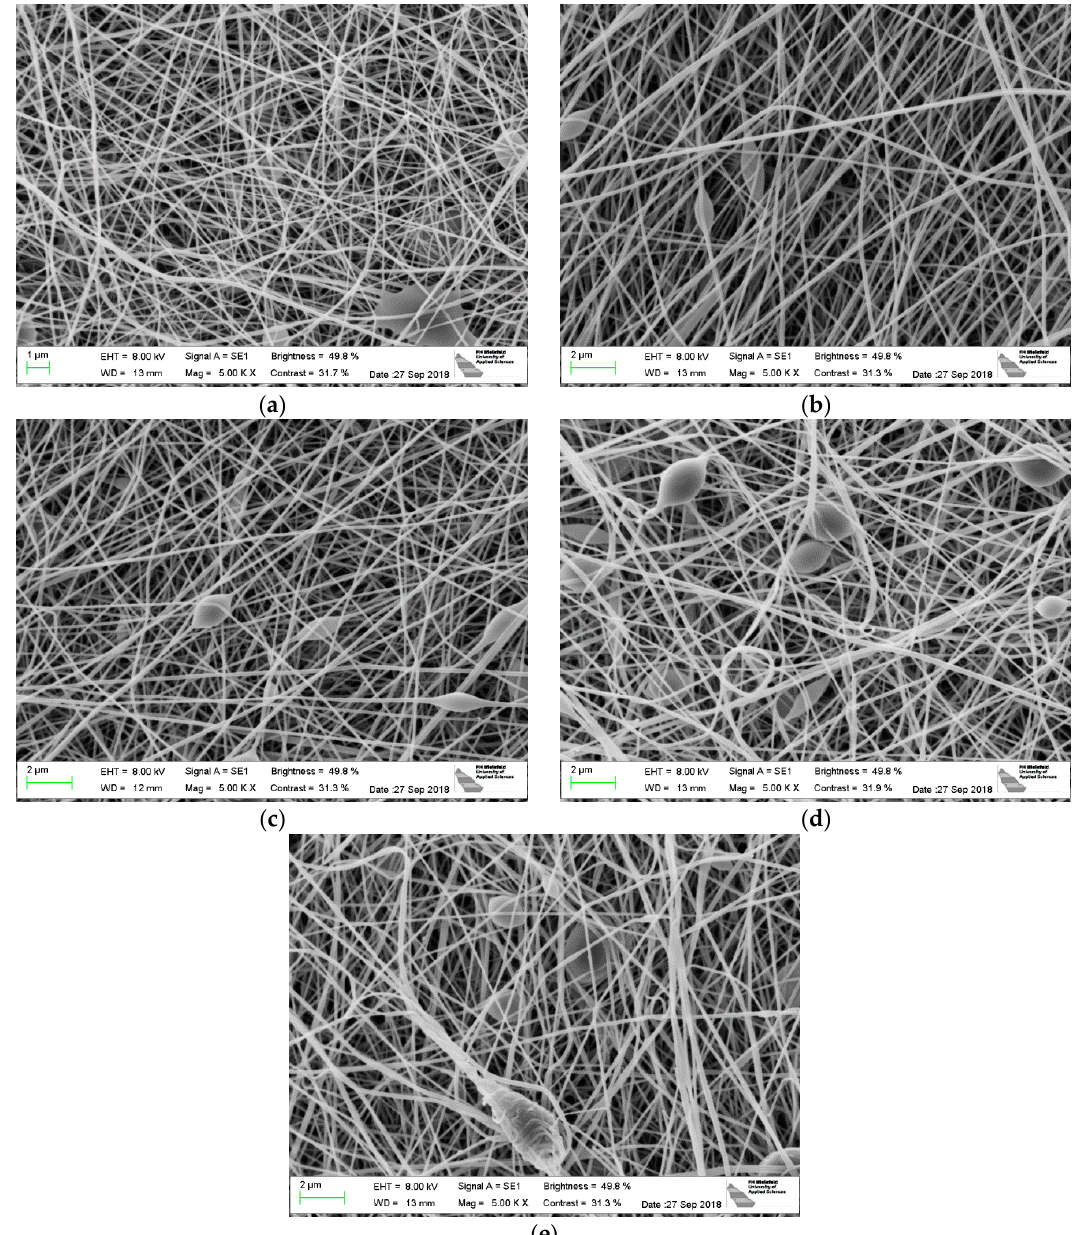
Figure 2. SEM images of electrospun PAN nanofiber mats with different spinning parameters (electrode-substrate distance / voltage): ( a ) 120 mm / 70 kV; ( b ) 180 mm / 60 kV; ( c ) 180 mm / 70 kV; ( d ) 240 mm / 70 kV; ( e ) 240 mm / 80 kV. All spinning durations were 30 min.